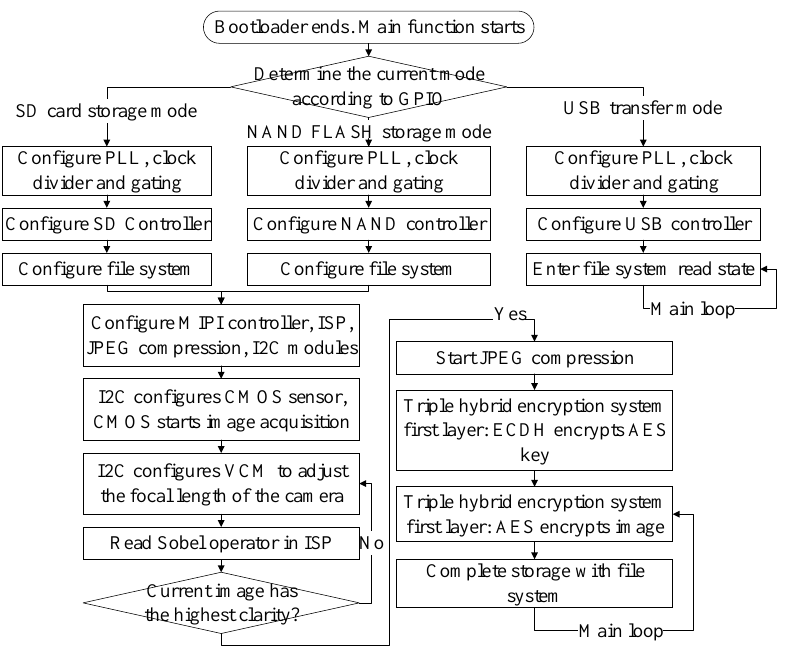
Figure 24. SoC software main